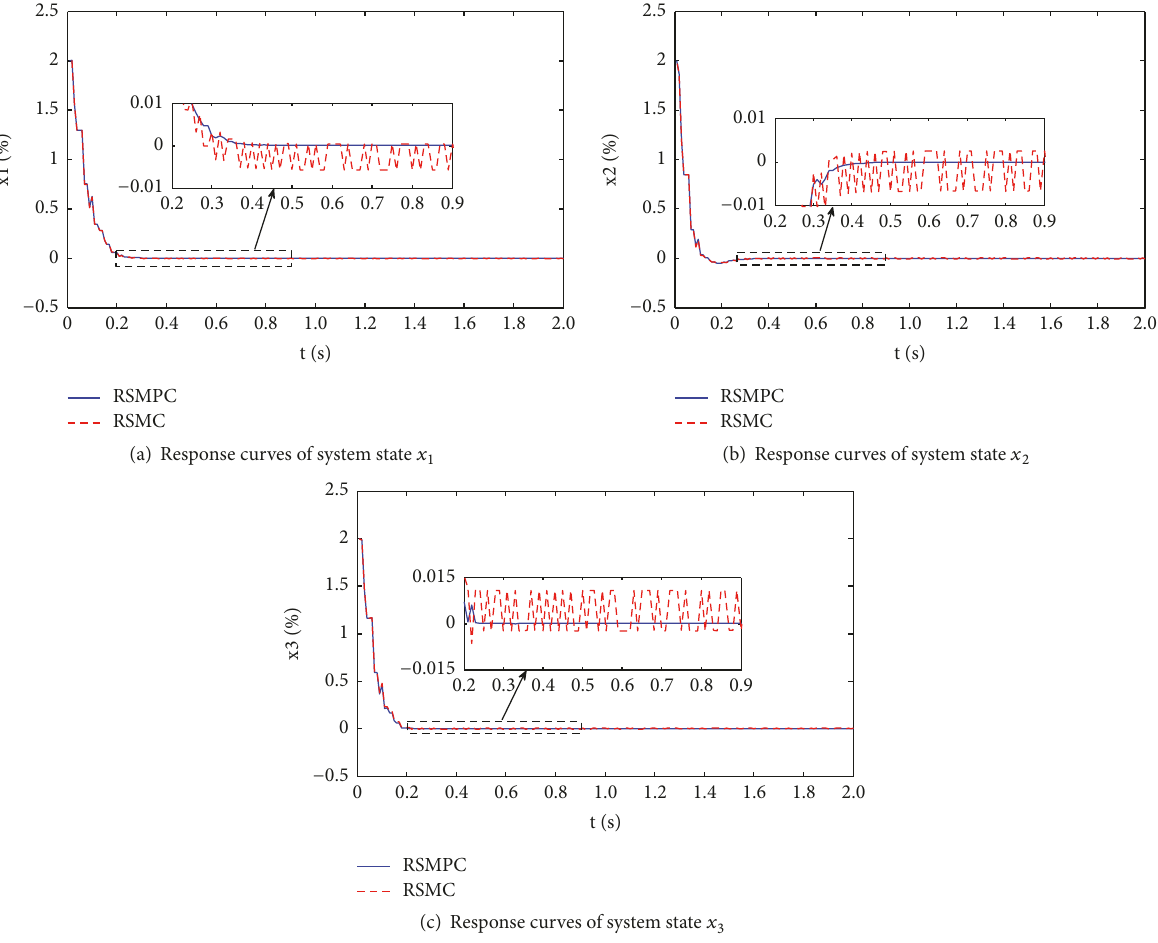
Figure 3: Response curves of system states with different